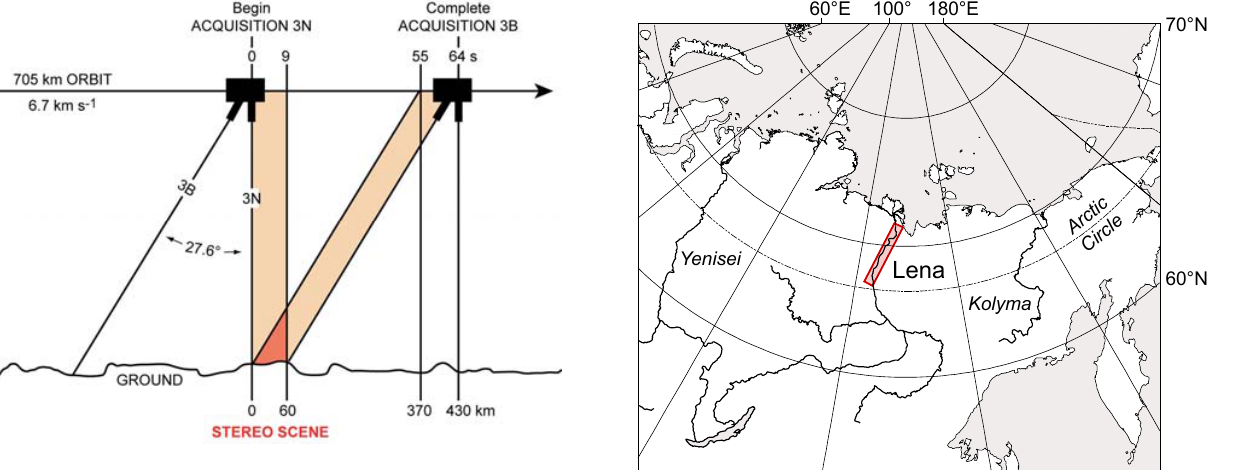
Fig. 2. Acquisition geometry of ASTER stereo. A 60km-long and Fig. 2 Acquisition geometry of ASTER stereo. A 60 km long and wide scene is acquired 641 -wide scene is acquired from the nadir sensor (here used: near- infrared band 3N), and then 55s later again from the back-looking from the nadir sensor (here used: near-infrared band 3N), and then 55 seconds later again 642 near-infrared stereo sensor producing band 3B. Bands 3N and 3B together form a stereo scene. from the back-looking near-infrared stereo sensor producing band 3B. Bands 3N and 3B 643